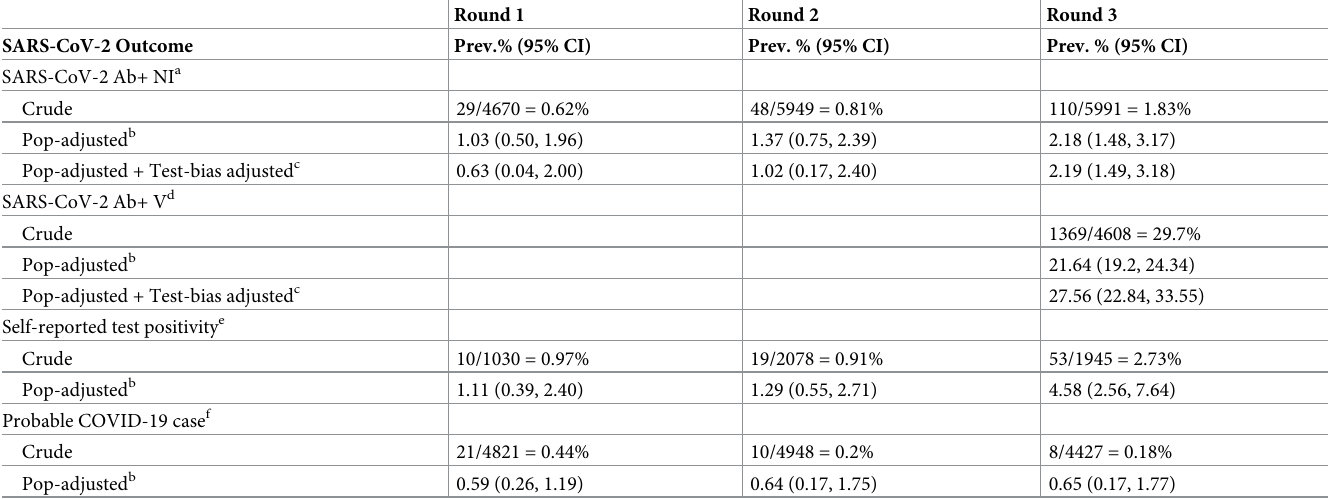
Table 3. Crude and population-adjusted prevalence (%) and 95% credible intervals of SARS-CoV-2 outcomes within the study